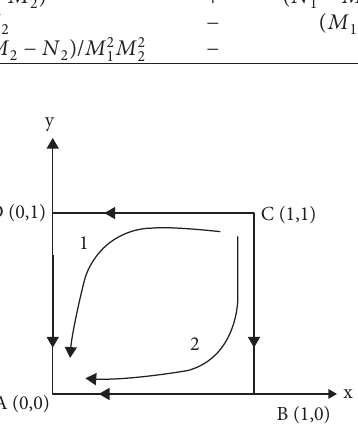
Figure 1: The stable strategy of the evolutionary game system when M Table 4: Stability analysis of equilibrium points when M